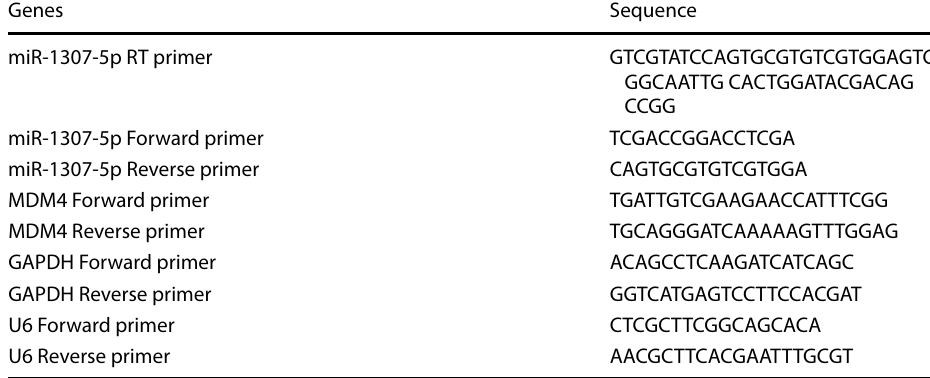
Table 1 Primer sequence